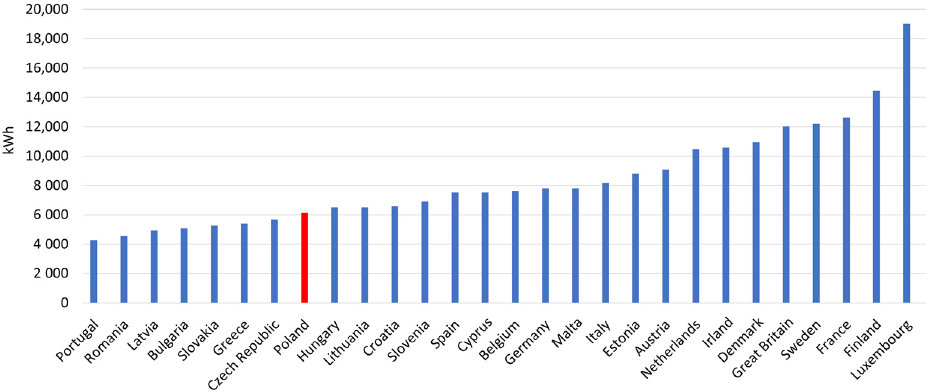
Figure 9. Affordability of electricity (in KWh) for average-income households in the EU (as of Au- gust 2022) [51]. 2022)